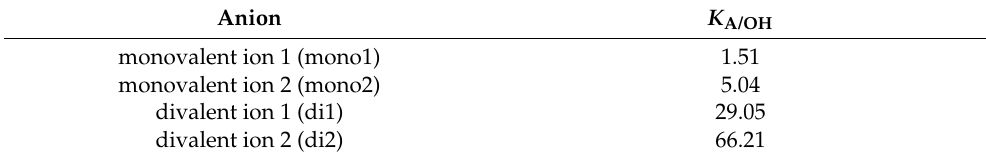
Table 2. The values of the ion-exchange selectivity coefficients of the anions used in this work. Anion K